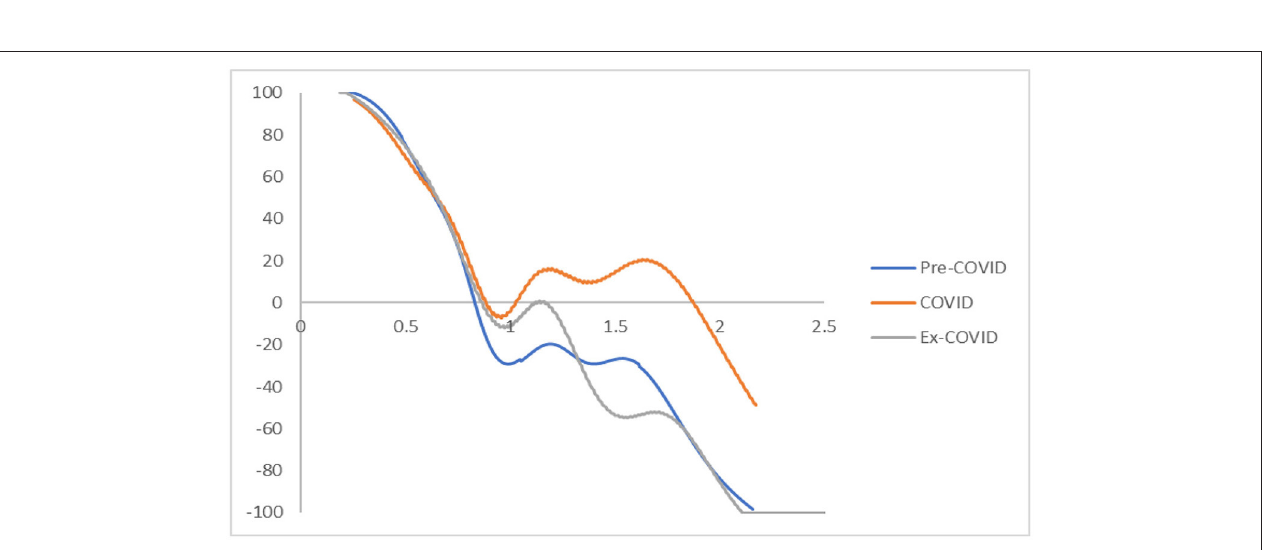
MPPs confirmed what can be seen in the transition